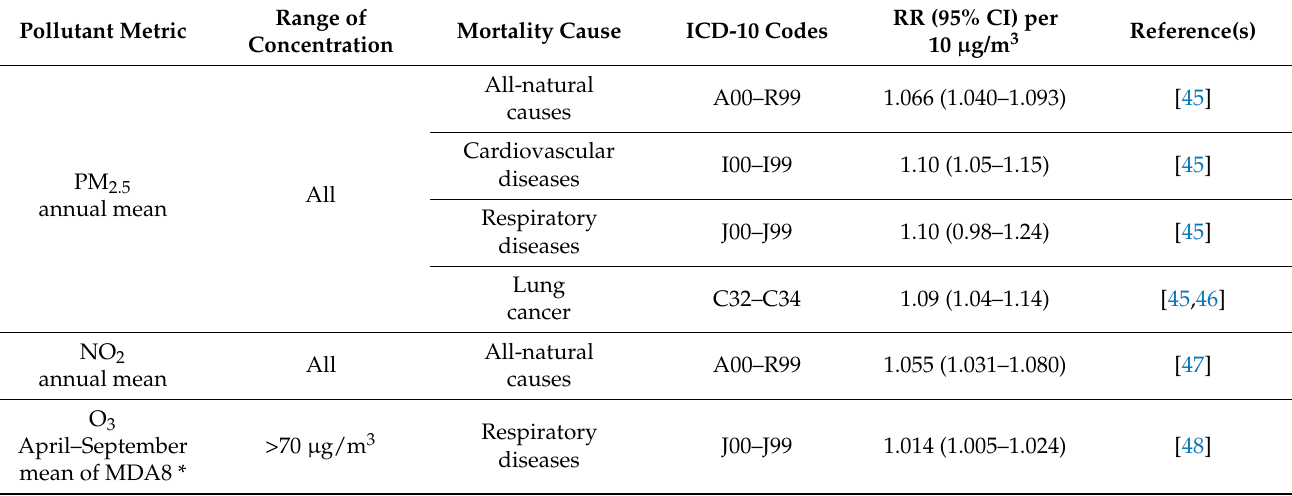
Table 2. Relative risks—World Health Organization. Values are calculated for people aged more than 30 years.